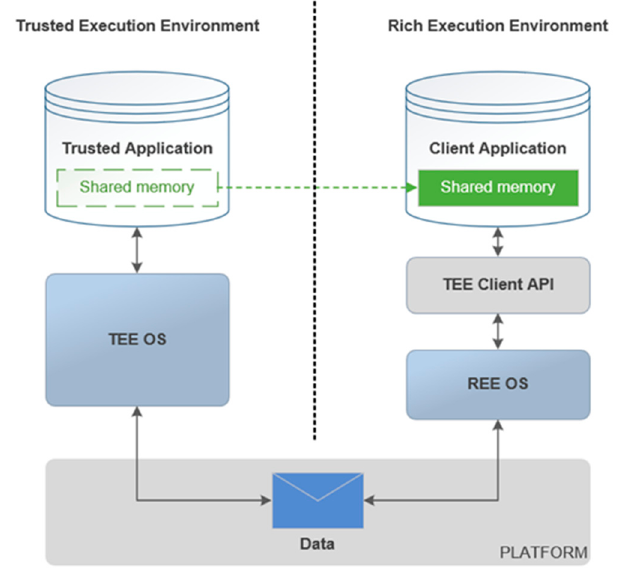
Figure 2. The interaction between Trusted Execution Environment (TEE) and Rich Execution Environment (REE).